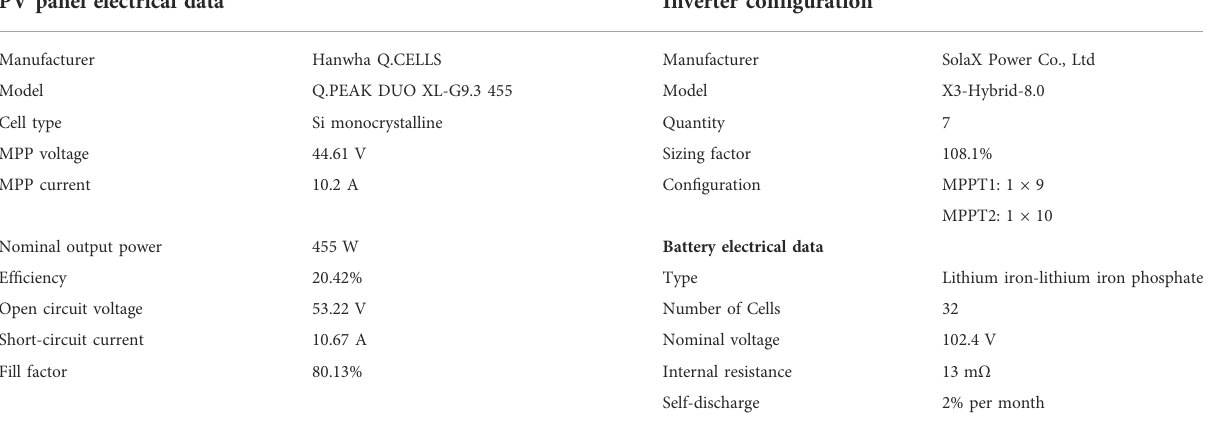
TABLE 3 PV panel characteristics at STC and battery and inverter con fi guration electrical